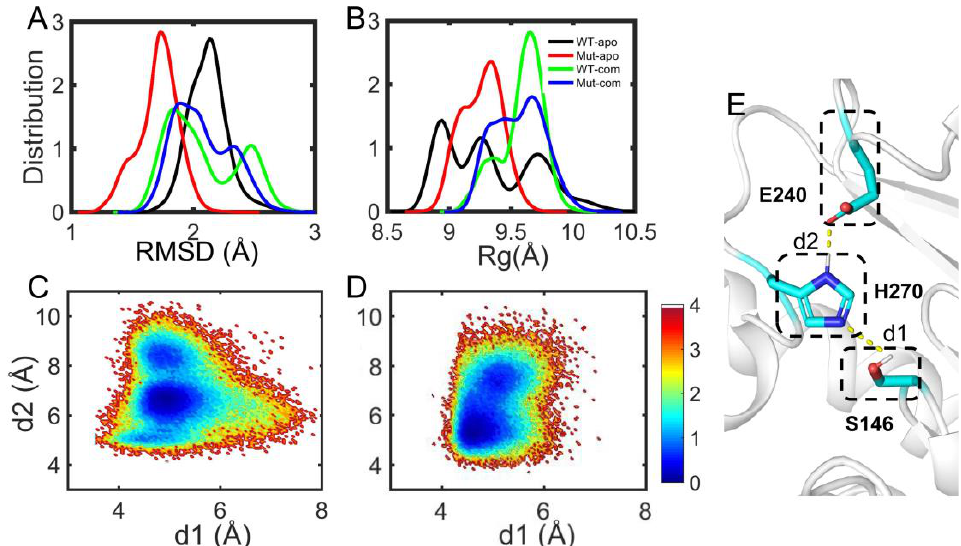
Figure 7. Substrate binding pocket analyses. The distribution of RMSD ( A ) and R g ( B ) of hydrophobic residues in the binding site. The free energy landscape distribution of the side-chain distances of the catalytic triad including S146-H270 (d1) and E240-H270 (d2) with lower energy minima basins colored in deep blue for WT-com ( C ) and Mut-com ( D ). ( E ) The local structure and hydrogen-bond network of the active site involving the catalytic triads .